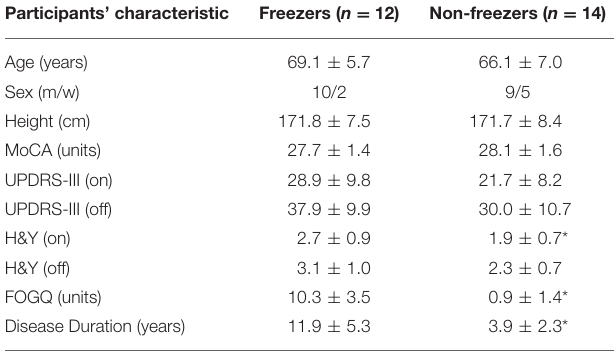
TABLE 1 | Participants’ characteristics and clinical evaluation results (mean ±